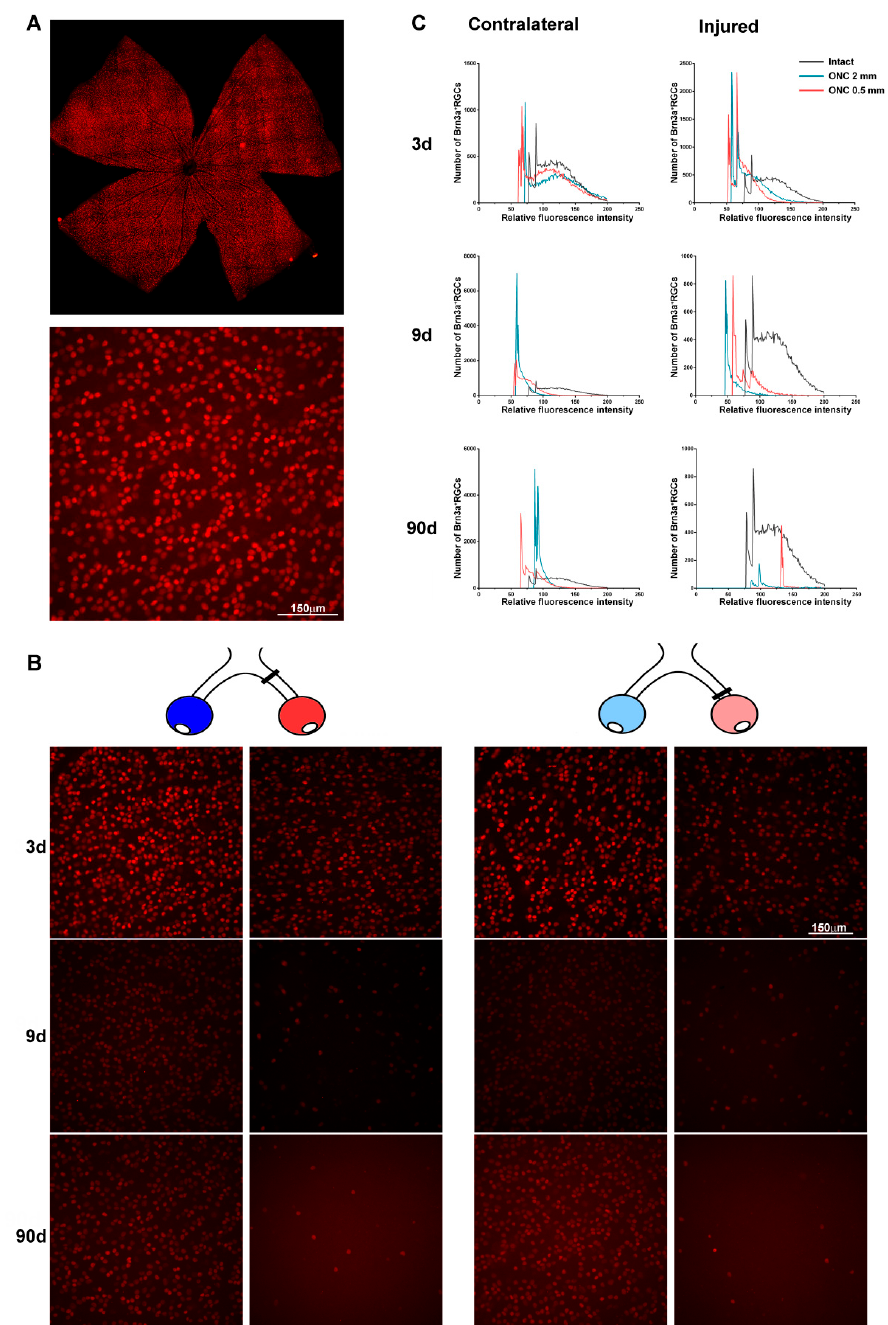
Figure 4. Brn3a expression in the injured and contralateral retinas: RGC death and transient down-regulation. ( A ) Brn3a immunodetection in a retinal photomontage (top) from the intact group, and a magnified view (bottom). ( B ) Brn3a magnifications from injured and contralateral retinas analysed at 3, 9, and 90 days after ONC 2 mm and ONC 0.5 mm. These images and the magnification in ( A ) were acquired with the same settings. In the injured and contralateral retinas, Brn3a signal was less bright than in intact retinas. At 90 days post-lesion, the signal of Brn3a per nuclei was stronger than at earlier time points. d: days post-lesion. ( C ) x-, y -plot showing the distribution of RGCs according to their expression level of Brn3a. The number of RGCs (ordinate axis) in intact retinas, injured and contralateral retinas analysed 3, 9, or 90 days after both ONC lesions was plotted against the intensity of their Brn3a signal. In both retinas, the mean intensity of Brn3a expression per nucleus decreased compared to intact retinas at 3 and 9 days but recovered at 90